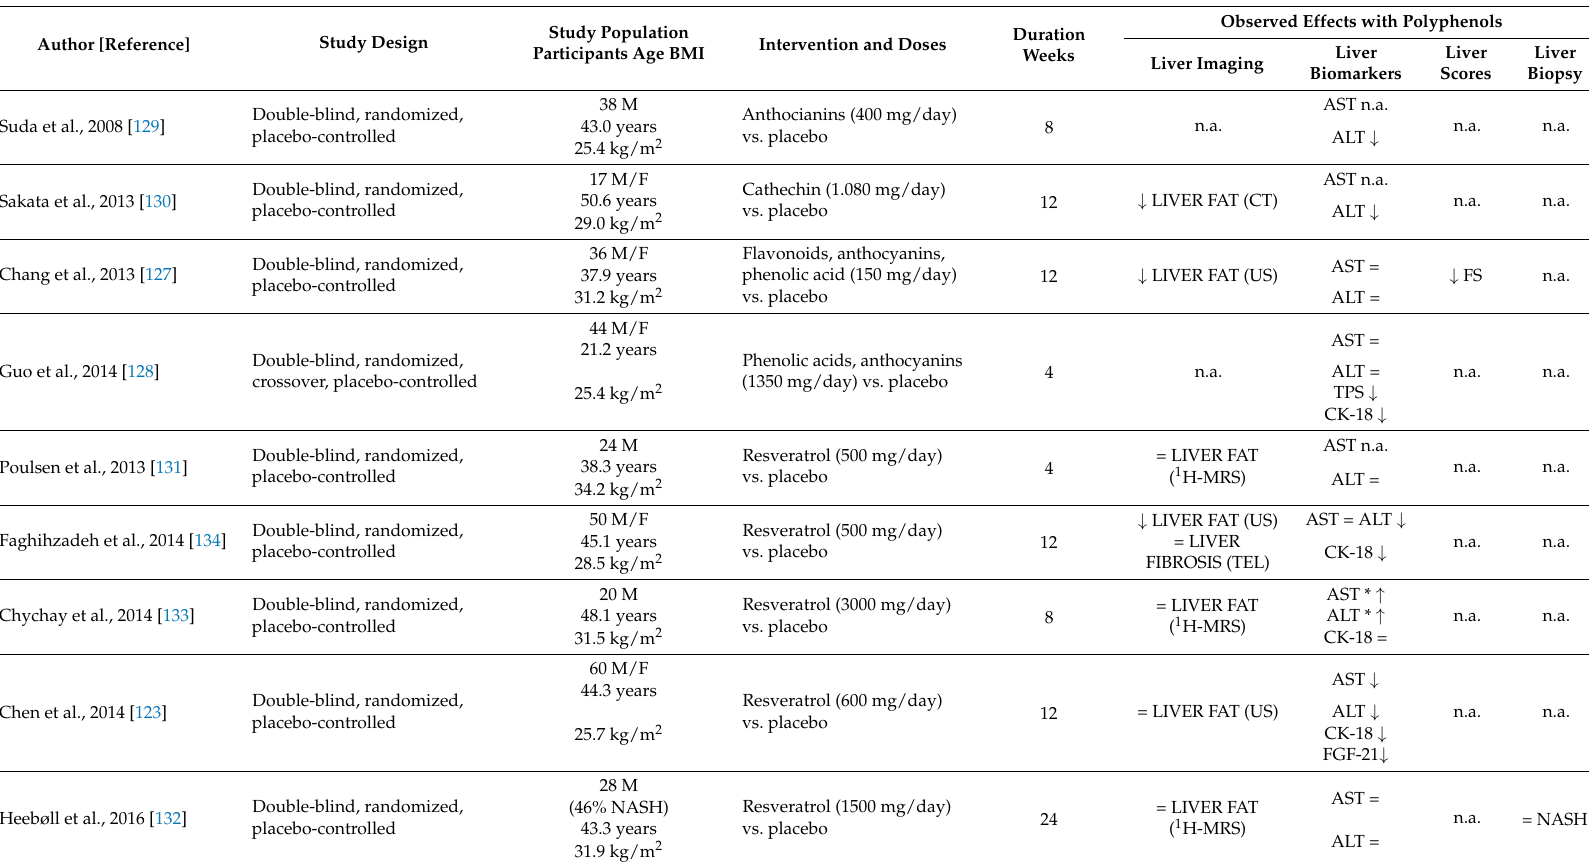
Table 4. Clinical trials on the effects of polyphenols supplementation on NAFLD in individuals at high cardiometabolic